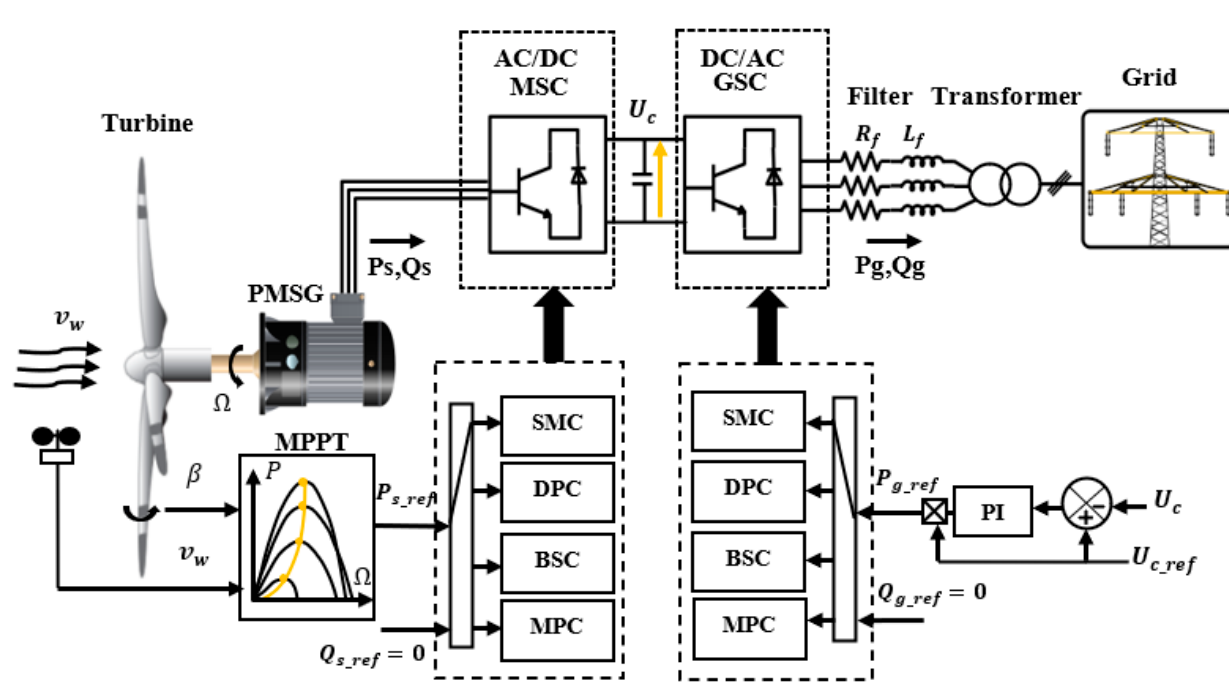
Figure 1. WECS configurations.